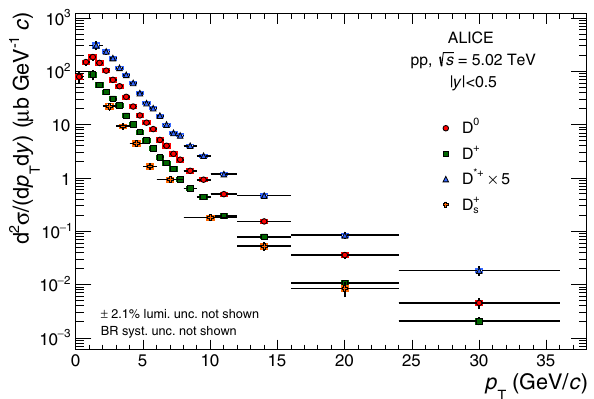
Fig. 7 p T -differential production cross section of prompt D 0 , D + , √ s = 5 . 02 TeV. Statisti- D ∗+ , and D + s mesons in pp collisions at cal uncertainties (bars) and systematic uncertainties (boxes) are shown. For the D 0 meson, the results in 0 < p T < 1 GeV / c are obtained from the analysis without decay-vertex reconstruction, while those in 1 < p T < 36 GeV / c are taken from the analysis with decay-vertex reconstruction. The D ∗+ -meson cross section is scaled by a factor of 5 for better